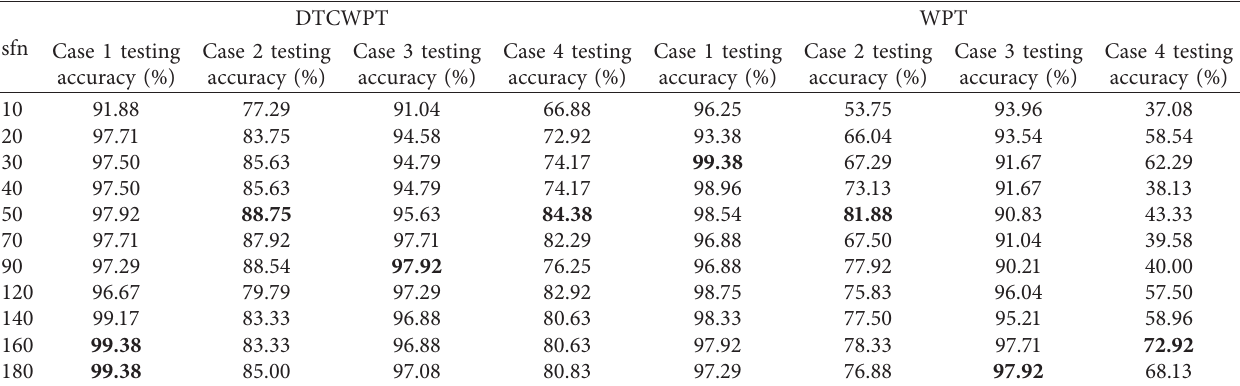
Table 12: Testing accuracies obtained by OFS-TSFRS-PCA-SVM.